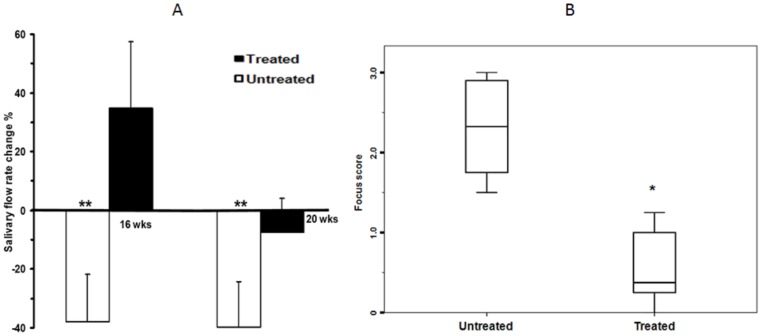
Salivary flow rates (SFRs,
Figure 1A
) and focus scores (
Figure 1B
) of the untreated and BM Soup-treated NOD mice (n = 6 mice per group).In Figure 1A, the white bars represent untreated NOD groups whereas the black bars represent treated NOD groups. **, p<0.01; *, p<0.05.